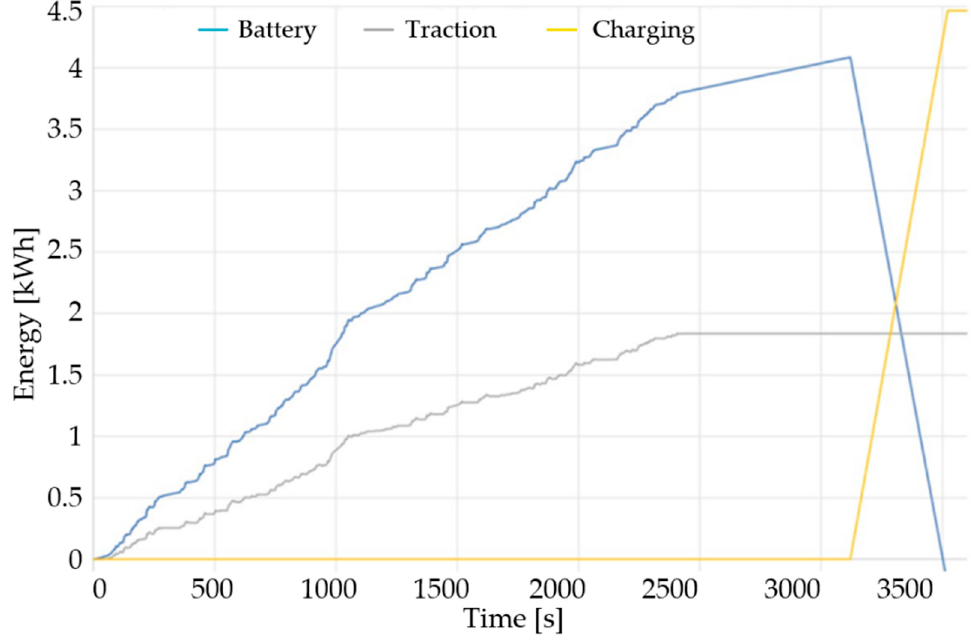
Figure 2. Energy consumption and charged during line 117 and recalculated for the “modified fast charge line” with high specific energy storage and a fast charge at the terminal with a flywheel as ground storage.